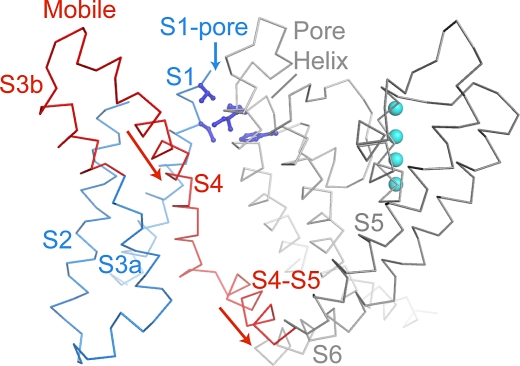
Model of Force Transmission in Kv ChannelsShown is a complete monomeric subunit of the paddle chimera (PDB ID: 2R9R) and the pore region only from the adjacent subunit with which the S1–pore interface is formed. Components of the voltage sensor that are mobile along the transmembrane axis are shown in red, and components that are static along the transmembrane axis are shown in blue. The pore regions are shown in gray. The side chains of the residues forming the S1–pore interface are shown in blue ball and stick rendition, and the potassium ions lining the filter region are shown as cyan spheres. The blue arrow denotes the location of the S1–pore interface with respect to the entire protein structure. The red arrows indicate the putative direction of force transmission from the voltage sensor onto the S4-S5 linker and from the S4-S5 linker to the pore.